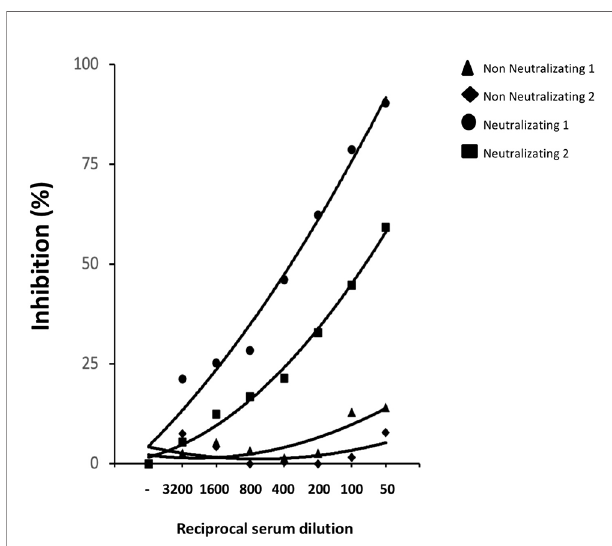
FIGURE 6 | Competition immune-enzymatic assay. Increasing amounts of human serum from two COVID-19 patients with nAbs or two healthy subjects were mixed with a fi xed amount of neutralizing R590 and R64 mAbs to perform a competitive ELISA. The reduction of the mAbs binding to HEK293T rRBD was measured as absorbance reduction and considered dependent on nAb concentration in sera. Results are expressed as percentage of inhibition compared to the maximum binding of R590 and R64 in the absence of the human anti-RBD neutralizing serum as competitor. Results from two representative neutralizing sera out seven and two non-neutralizing out of six are